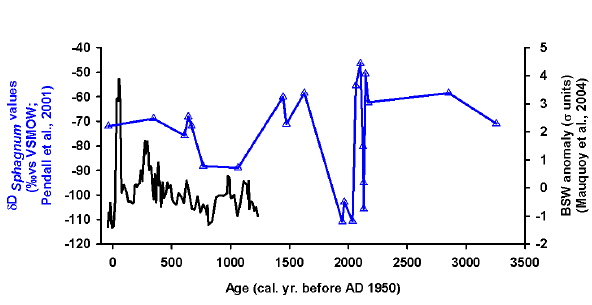
Fig. 8. Peatland hydroclimatic (AND-1; Mauquoy et al., 2004) and stable isotopic records (Harberton Bog; Pendall et al., 2001) from Tierra del Fuego. Blue line and triangles=palaeo stable isotope record from Harberton Bog. Black line=bog surface wetness recon- struction based on plant macrofossil data from Andorra Bog (more positive values indicate a drier bog